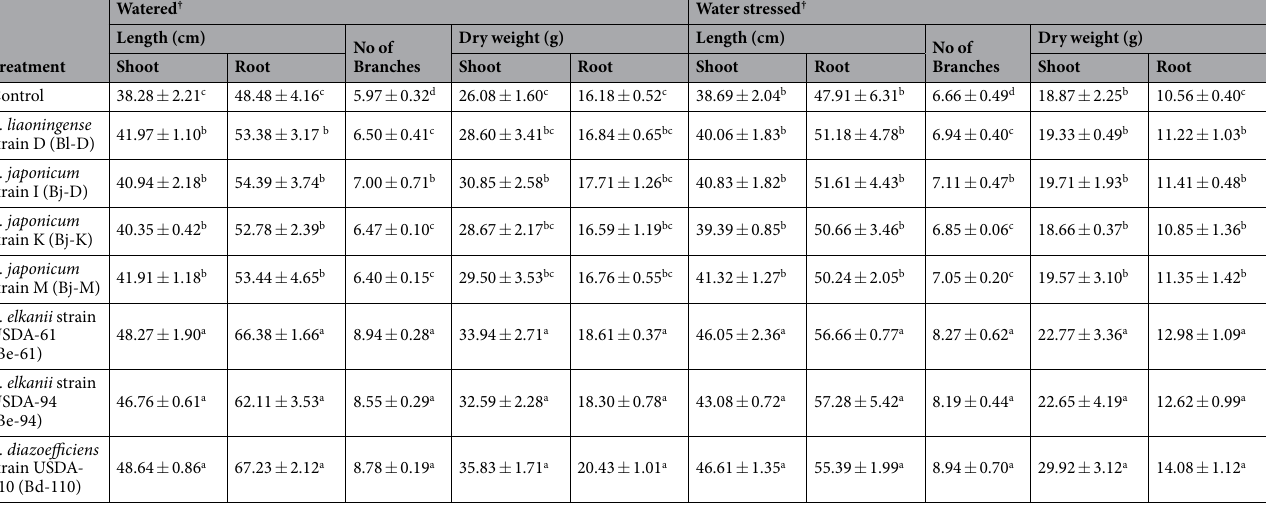
Table 2. Inoculation effects of non-rhizobitoxine- and rhizobitoxine-producing Bradyrhizobium strains on plant growth and biomass accumulation of soybean plants under watered and water-stressed conditions. † Values are the means of six-replication ± standard error. Values with the same superscripts within column indicate no significant difference at P ≥ 0.05.